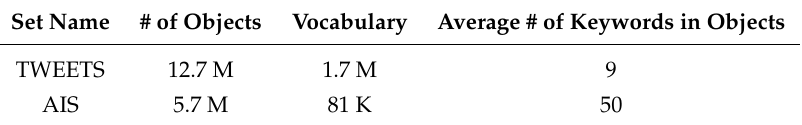
Table 1. Datasets.